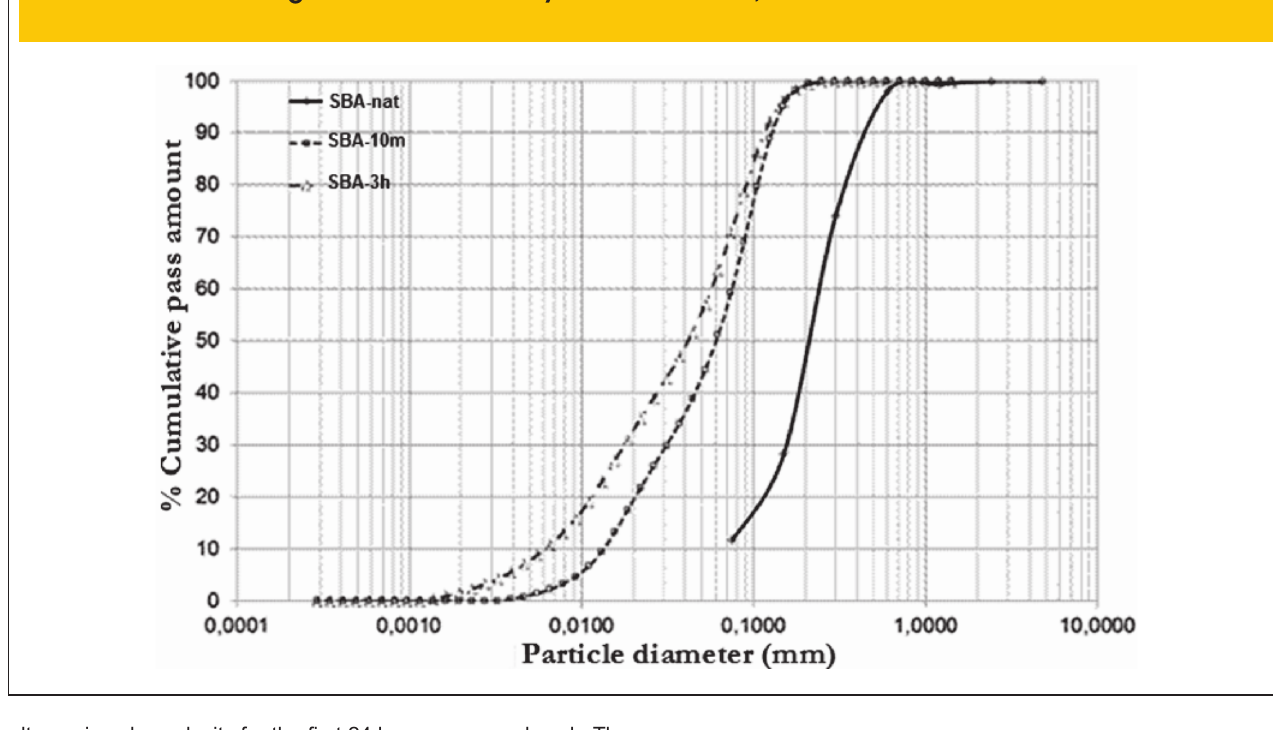
Table 2 – Chemical composition of sugarcane bagasse ash in